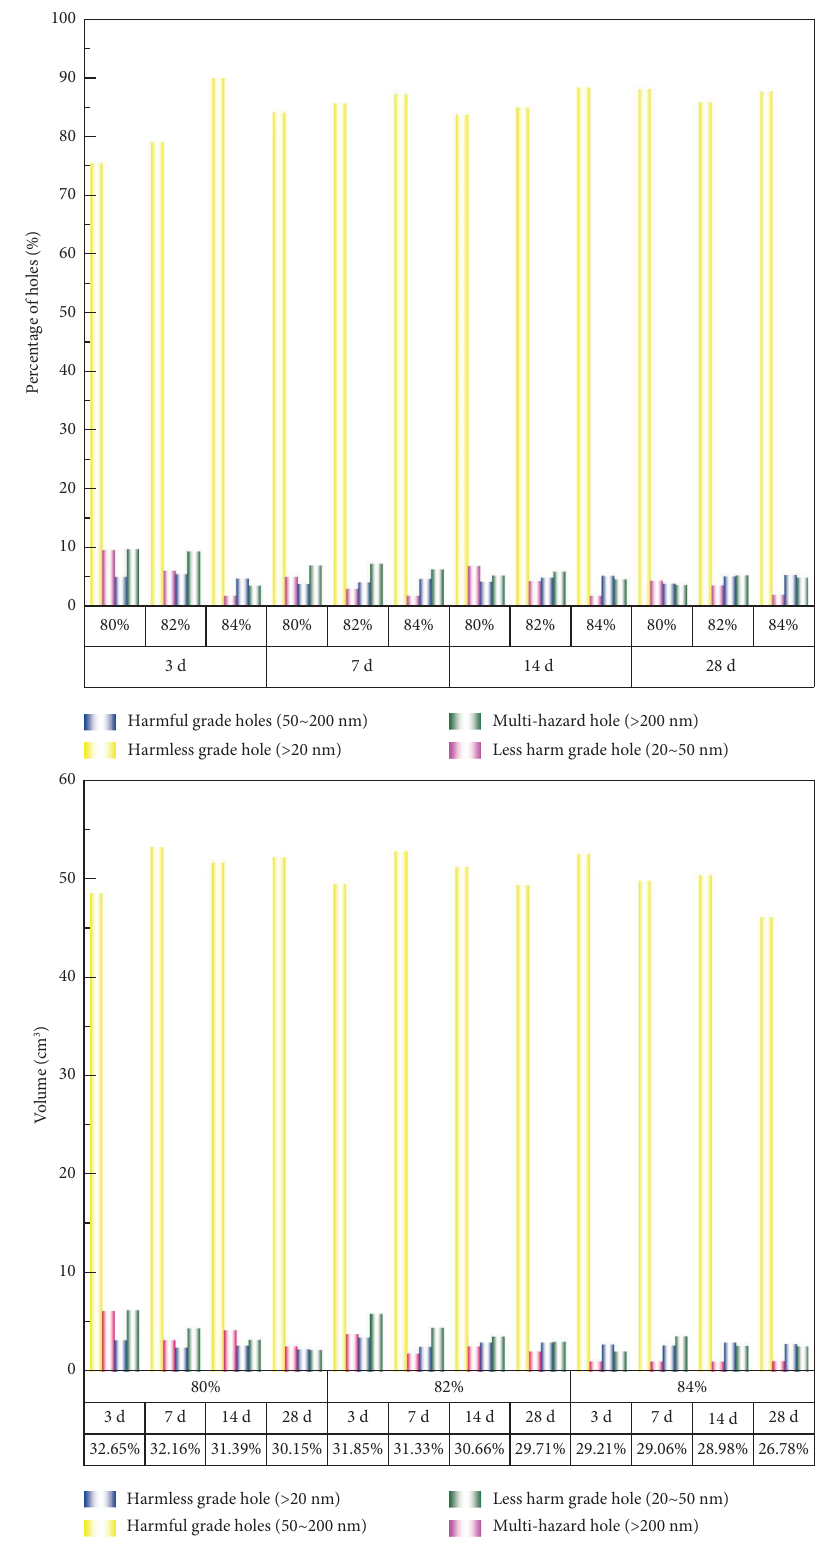
Figure 9: Proportion and distribution of pore size of CGGCFB at diferent ages and diferent mass